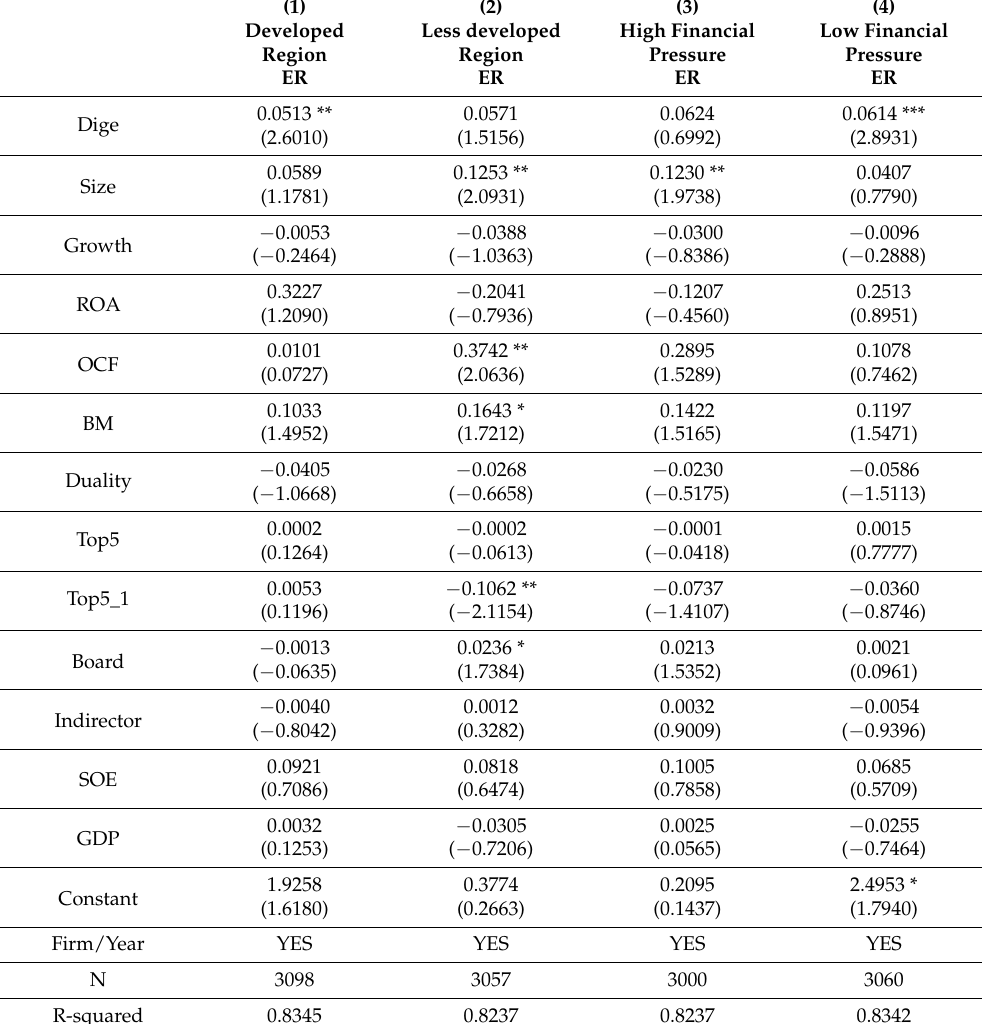
Table 10. Heterogeneity between regional economic development level and local government finan- cial